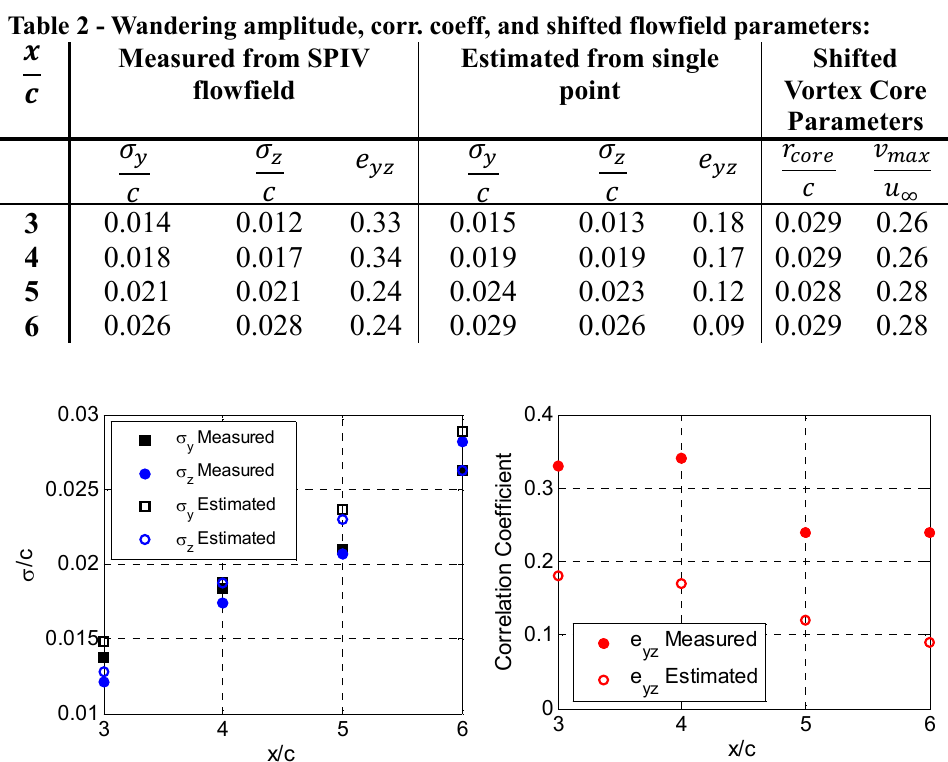
Figure 4 – Measured and Estimated wandering amplitude and correlation